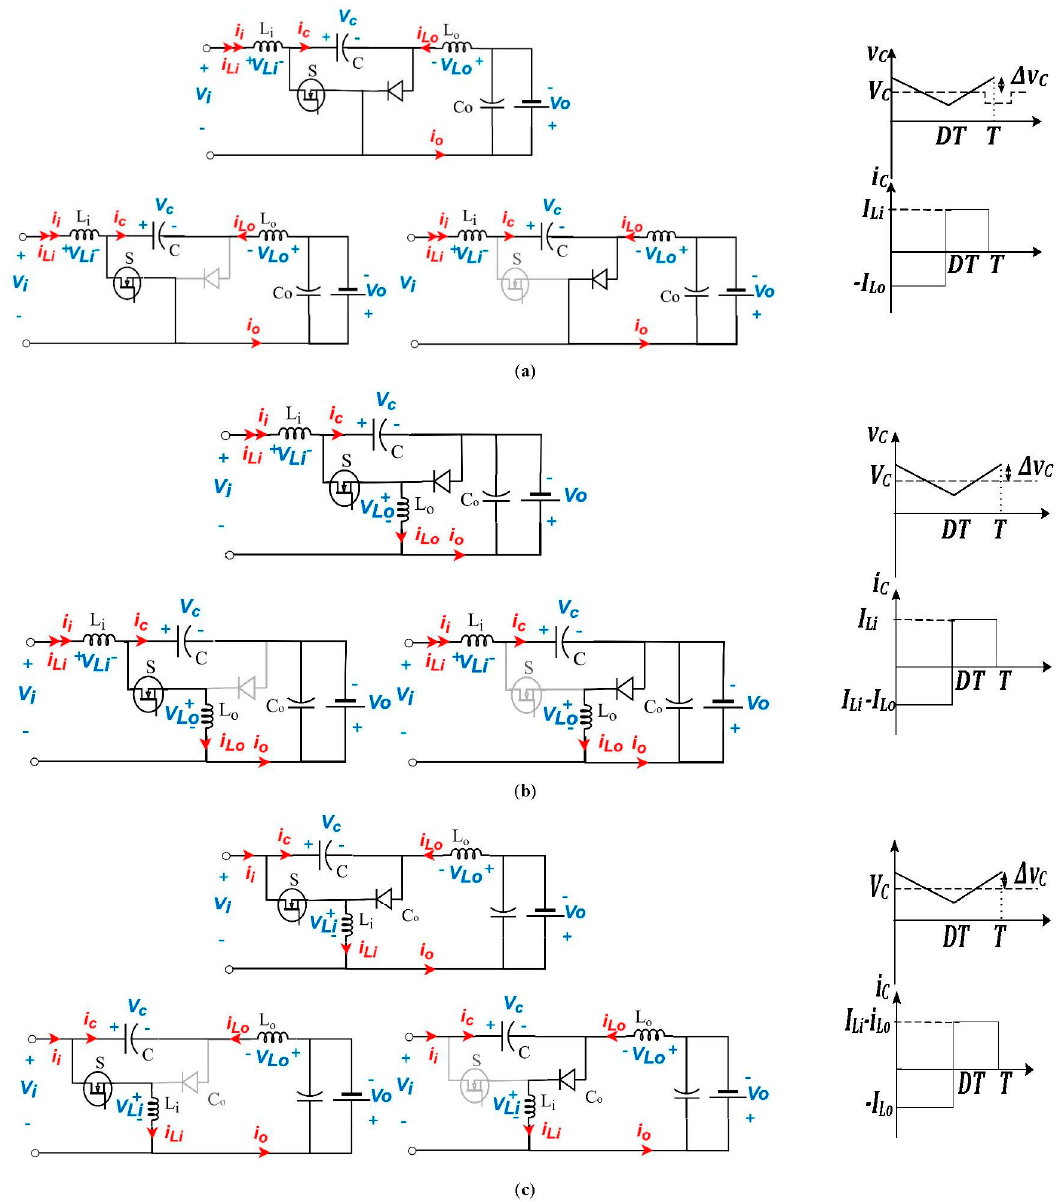
Figure 1. Circuit topology for: ( a ) CUK; ( b ) D1; ( c ) D2 converters.